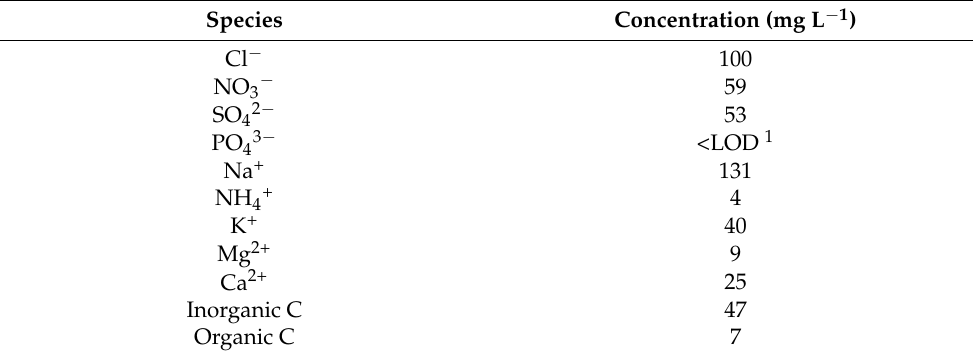
Table 1. Concentration of inorganic ions and inorganic and organic